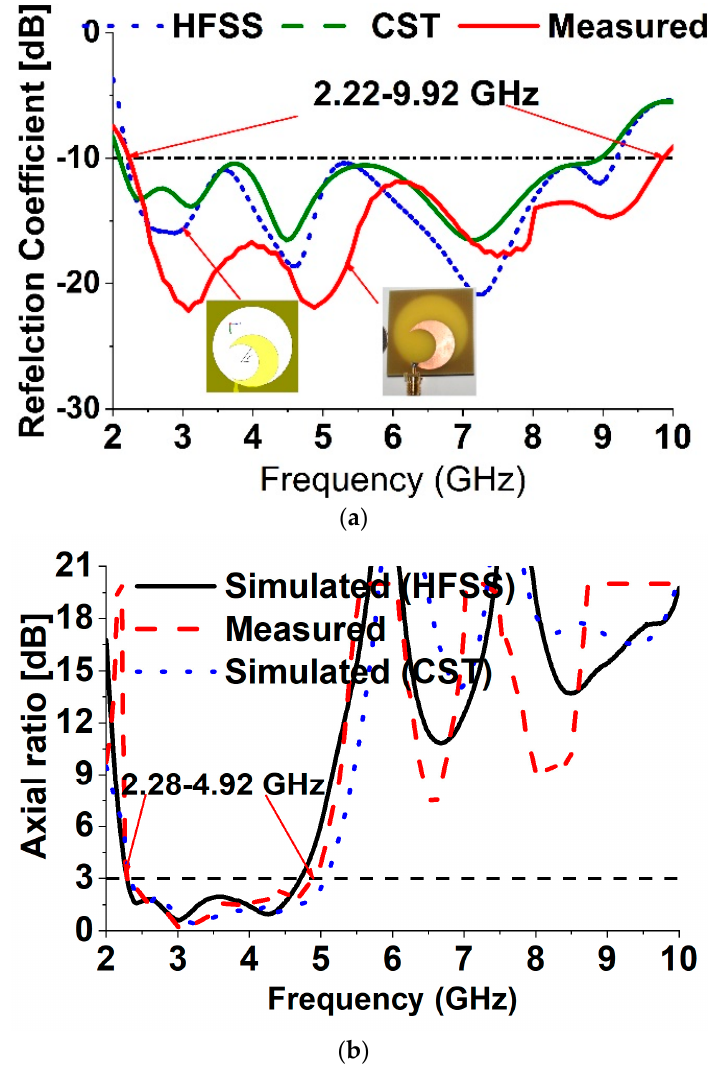
Figure 6. The numerical and measured results of ( a ) S 11 (Reflection coefficient) and ( b ) ARBW.